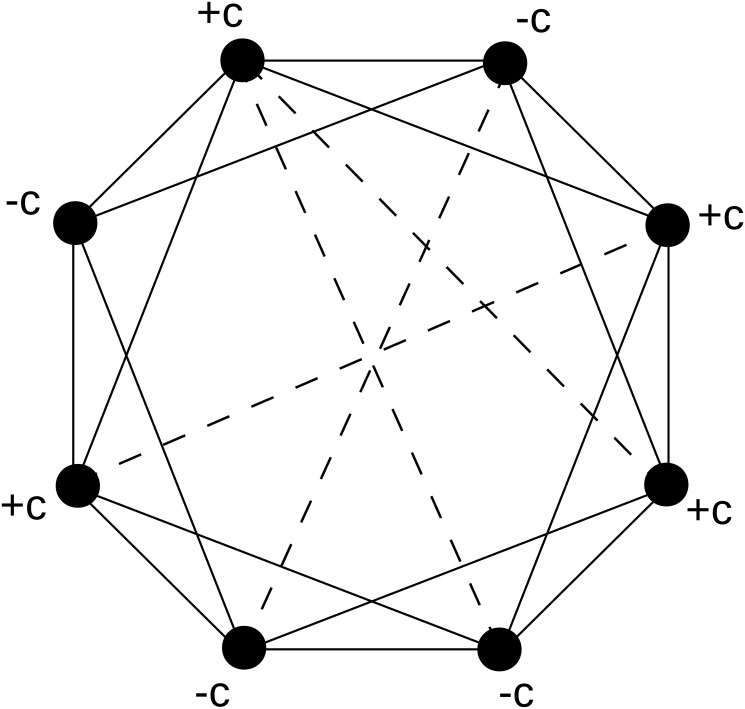
Actors network example.Here labels +c and −c correspond to cooperative and competitive actor, respectively. In this case, we represent cases for which r∼48=0.5 and p ∼ 0.25. Solid lines correspond to links in the regular ring, while the dashed ones are the extra-connections.